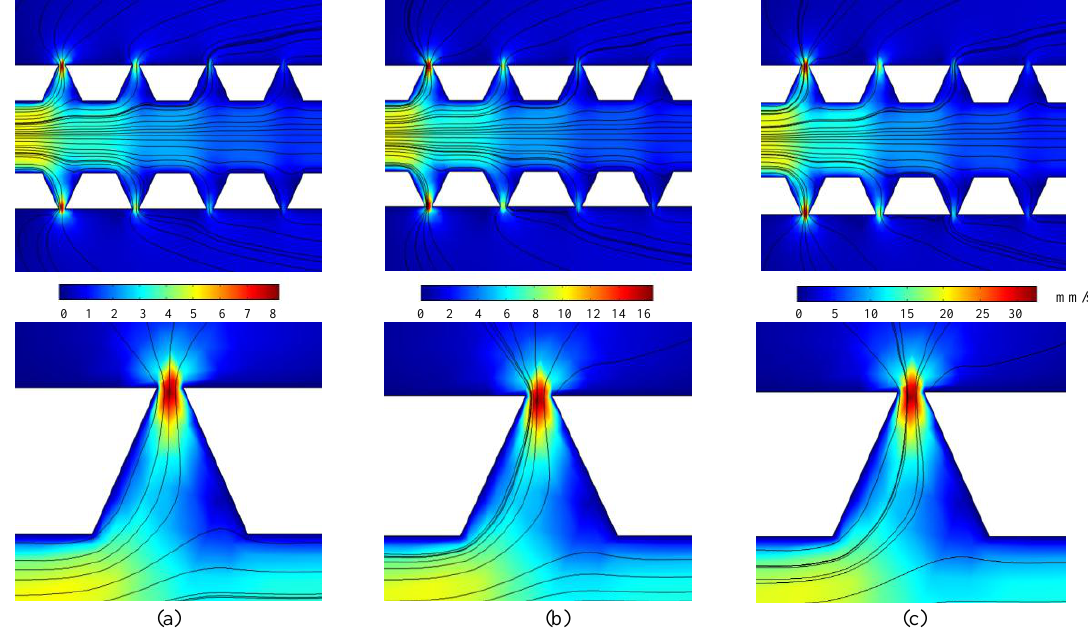
Figure 2. Simulation results for the velocity field under the three different main flow rate conditions. The side flow rates in all cases were kept at 5 nL·min −1 . Jet flows were formed at the bottom of the flow nozzles. The flow velocity reached its maximum at the bottom of trap 1 and trap 2 and decreases along the channel due to the partial leakage of the flow to the side channels. Streamlines of the velocity field show the portion of the flow diverged from the main channel to the side channels. ( a ) The flow rate in the main channel was 25 nL min −1 and the maximum flow velocity was 8.2 mm/s; ( b ) the flow rate in the main channel was 50 nL min −1 and the maximum flow velocity was 16.4 mm/s; and ( c ) the flow rate in the main channel was 100 nL·min −1 and the maximum flow velocity was 32.5 mm/s. Surface: Velocity magnitude (mm/s) Streamline: Velocity